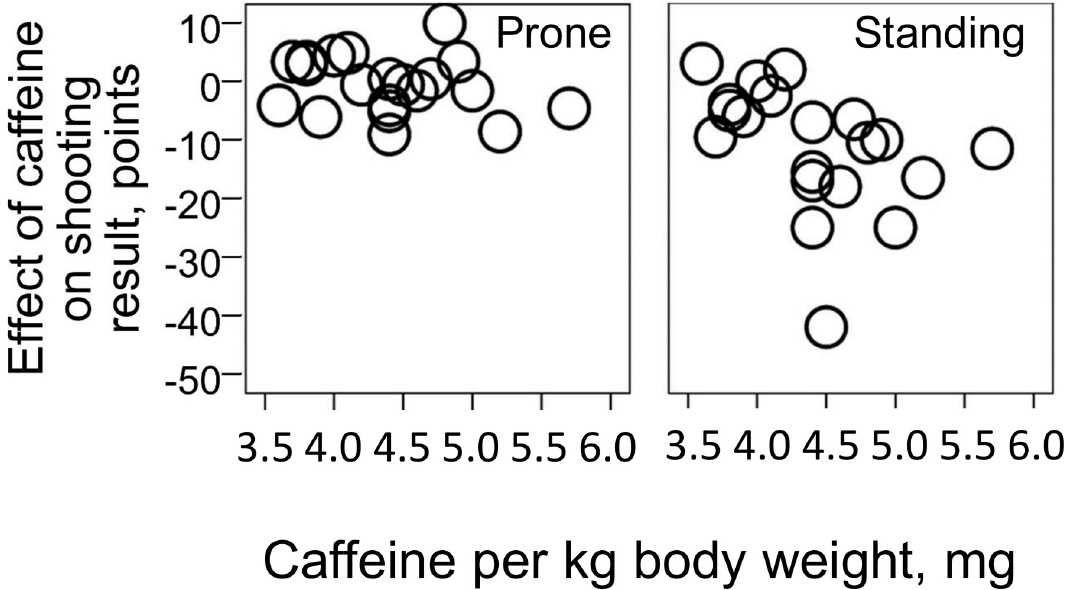
Fig 3. Effect of the amount of caffeine per kg bodyweight on shooting performance. Effect of the relative dose of caffeine ingested before shooting (300 mg caffeine divided by bodyweight on the x axis in both plots) on the difference between shooting results after caffeine and placebo ingestion (y axis), for the results from prone and standing position separately. beat per minute (95% CI: -4 to 2) lower during shooting with caffeine compared to placebo. This was a result of 0 (95% CI: -5 to 4) difference in prone position and 2 beats lower per minute (95% CI: -6 to 1) with caffeine compared to placebo in the standing position. There were no sig- nificant interaction between heart rate and the effect of caffeine on shooting performance.